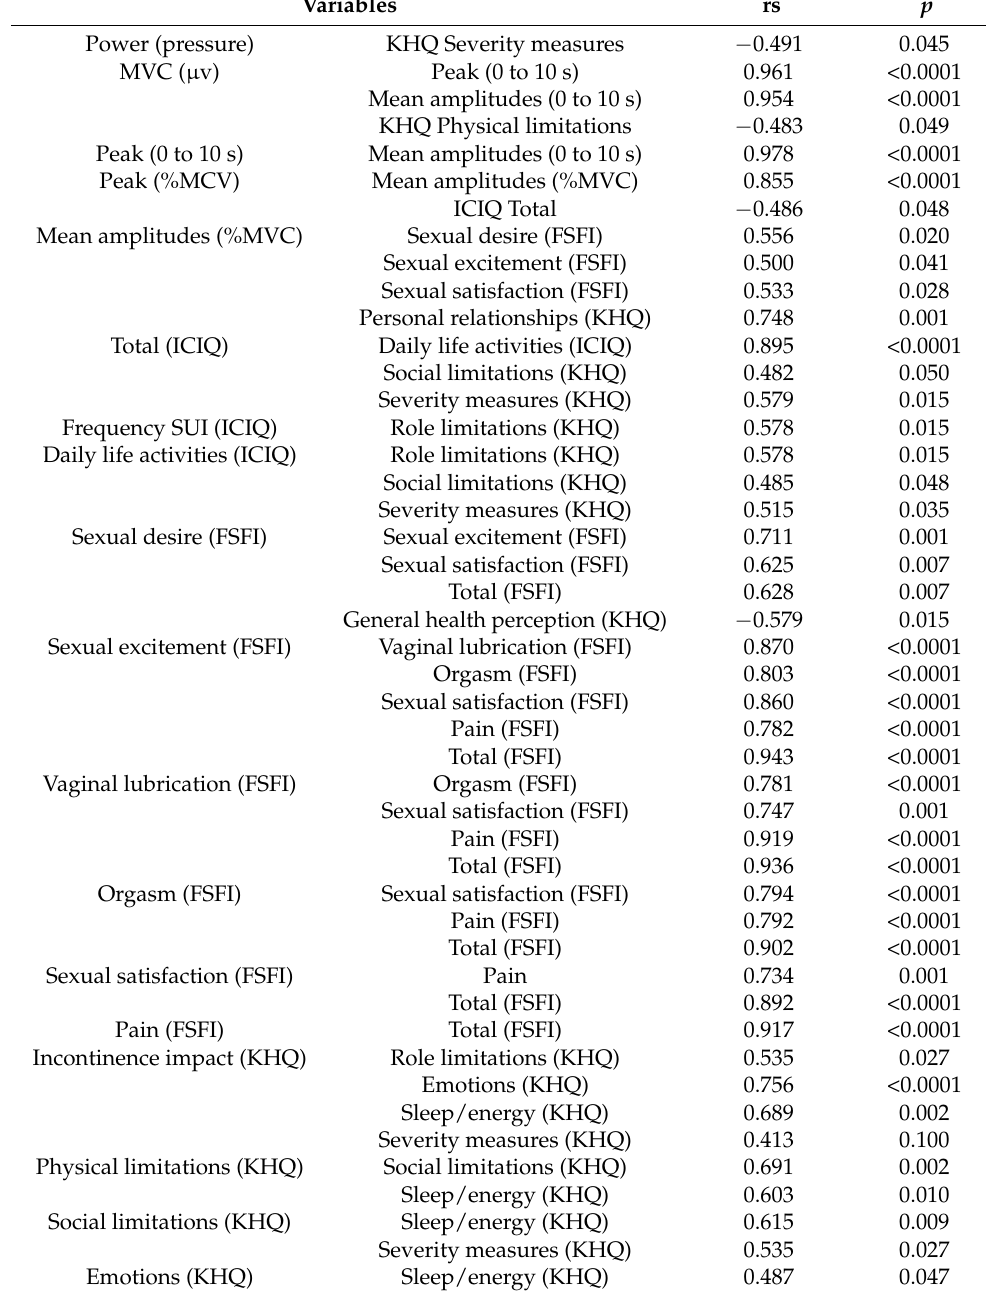
Table 3. Correlation among variables in women with stress urinary incontinence (SIU)